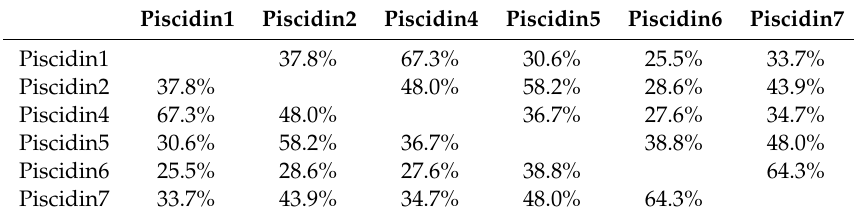
Figure 2. Alignment of sea bass piscidins. Signal peptides are shaded gray and predicted cleavage sites are underlined. Identical residues are denoted by (*), conserved substitutions by (:) and semi-conserved substitutions by (.). Table 2. Identity scores of full length sea bass piscidin amino acid sequences.